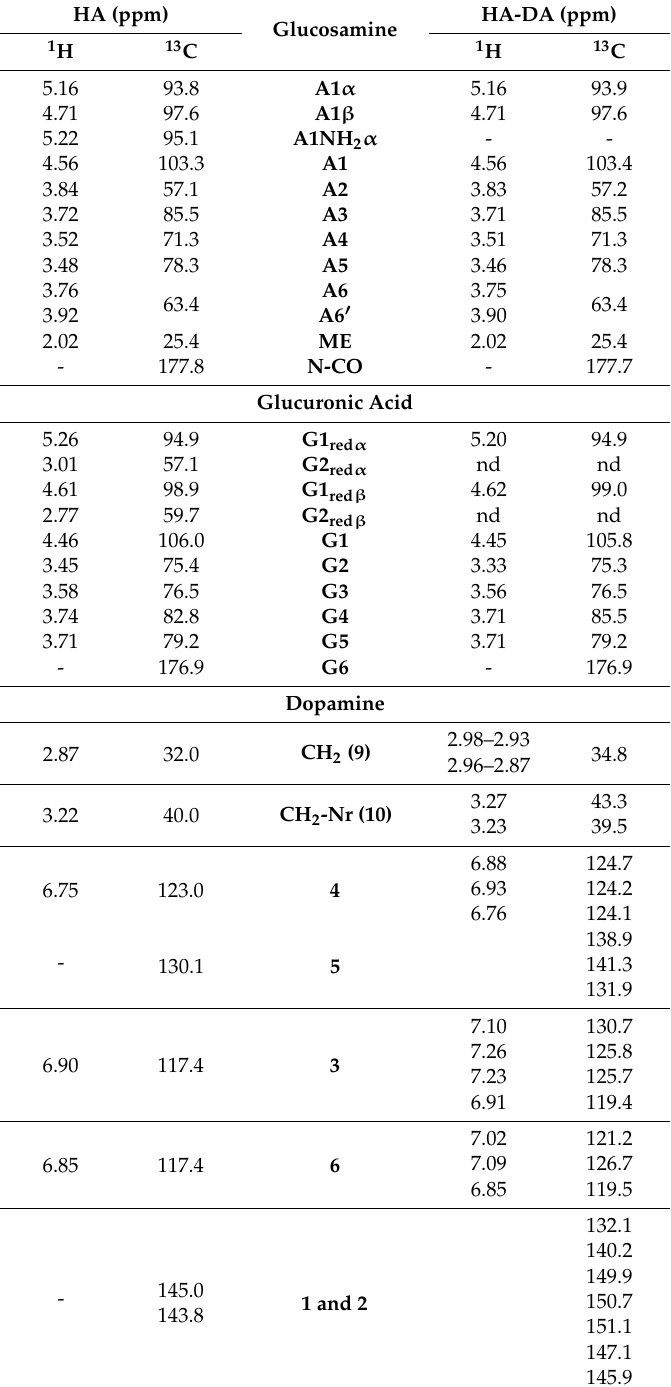
Table 1. Proton 1 H and carbon 13 C structure-chemical shift assignment of hyaluronic acid (HA) and HA-dopamine (DA). Italics: free DA. The numbers used for the attribution of DA signals refer to the DA structure reported in Figure